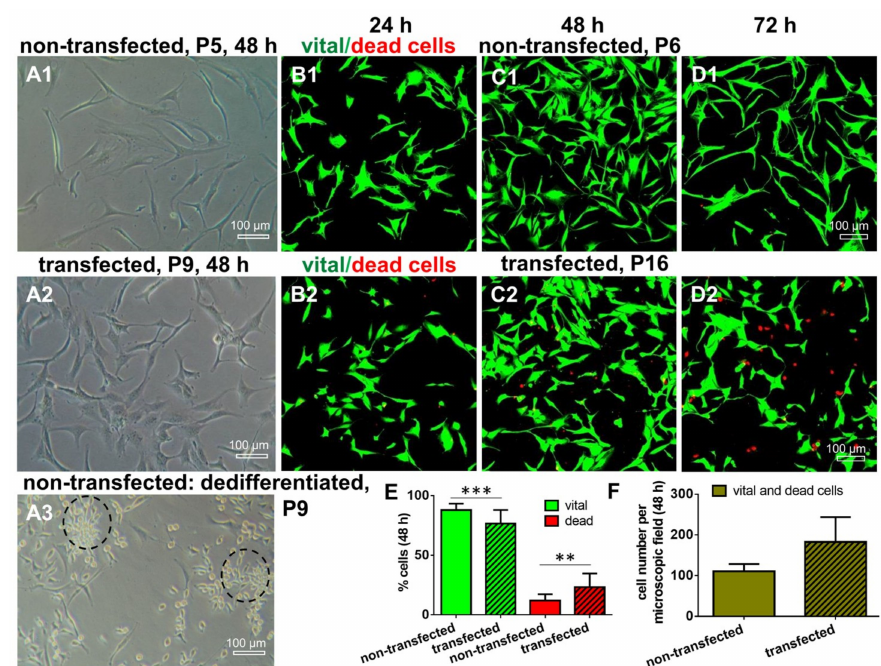
Figure 3. Survival of non-transfected and transfected human ACL ligamentocytes. ( A1 , A2 ) Images of non-transfected and transfected cells. ( B1 , C1 , D1 ) Live / Dead assay of non-transfected cells and of SV40 transfected cells cultured in monolayer for 24, 48, and 72 h ( B2 , C2 , D2 ). ( A3 ) Non-transfected cells dedi ff erentiated in monolayer passage (P9) reflecting clusters of round proliferating cells (dashed circles). ( E ) Comparison of the percentage of vital (green) and dead (red) cells in non-transfected and SV40 transfected ACL ligamentocytes (48 h). ( F ) Comparison of the total number of cells per microscopic field after 48 h monolayer culture of non-transfected and transfected cells (n = 3, with three evaluated microscopic fields each). Scale bars: 100 µ m. * p < 0.05, *** p <